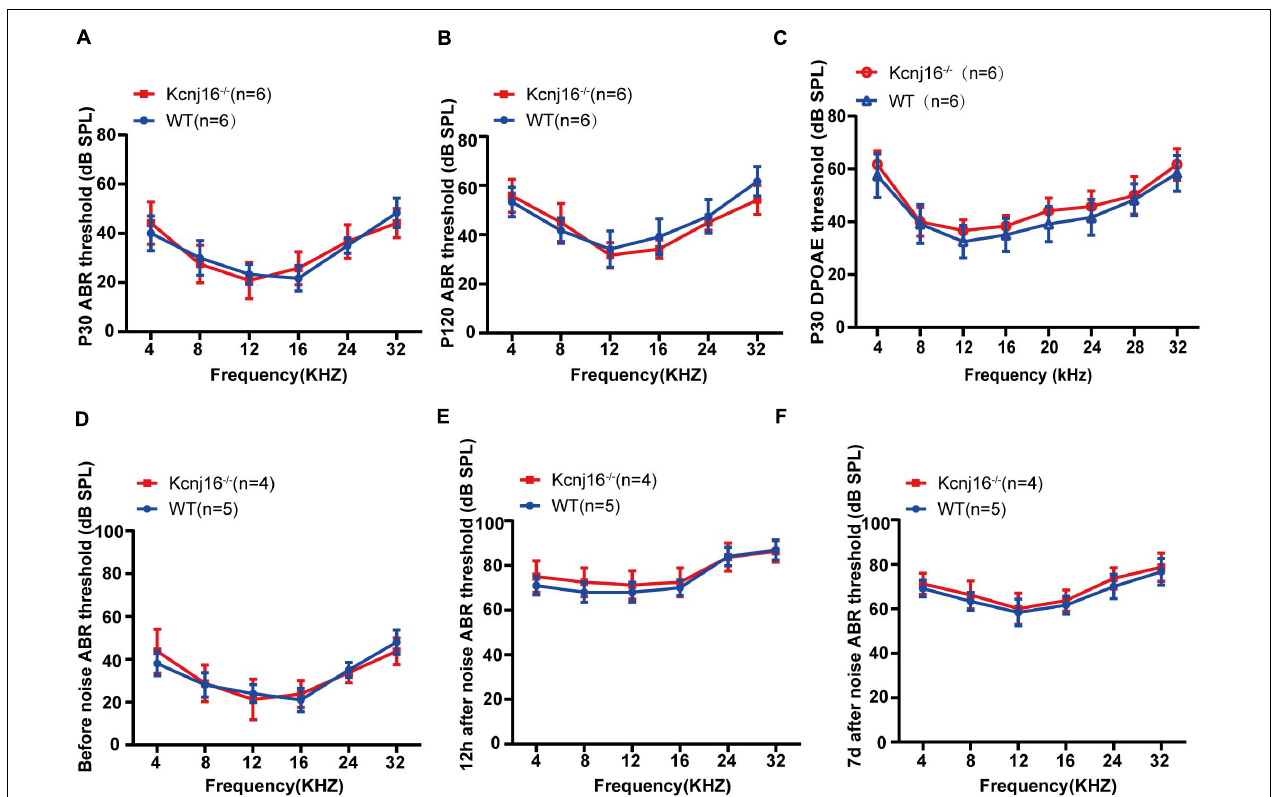
FIGURE 5 | Kcnj16 − / − mice showed no changes in auditory function. (A,B) ABR thresholds of P30 and P120 Kcnj16 - / − and WT mice were measured at 4, 8, 12, 16, 24, 28, and 32 kHz. (C) DPOAE thresholds were measured in response to tone bursts of 4, 8, 16, 20, 24, 28, 32, 36, and 40 kHz in P30 Kcnj16 − / − and WT mice. (D–F) The ABR thresholds of P30 Kcnj16 − / − and WT mice were measured before, 12 h after, and 7 days after noise exposure. No significant differences were observed between Kcnj16 − / − and WT mice ( p > 0.05). Data are presented as means ±